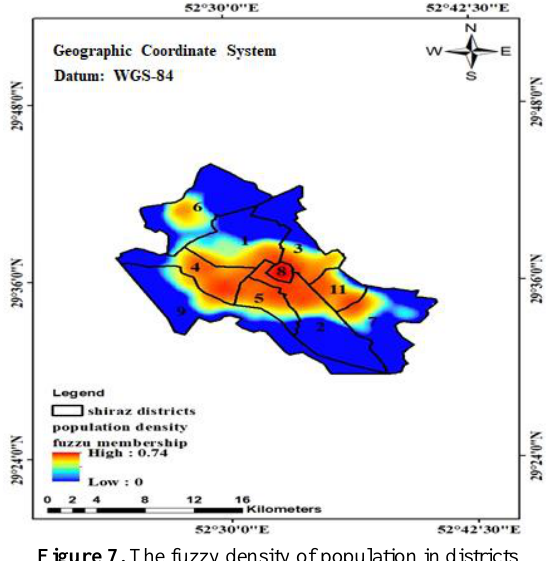
Figure 7. The fuzzy density of population in